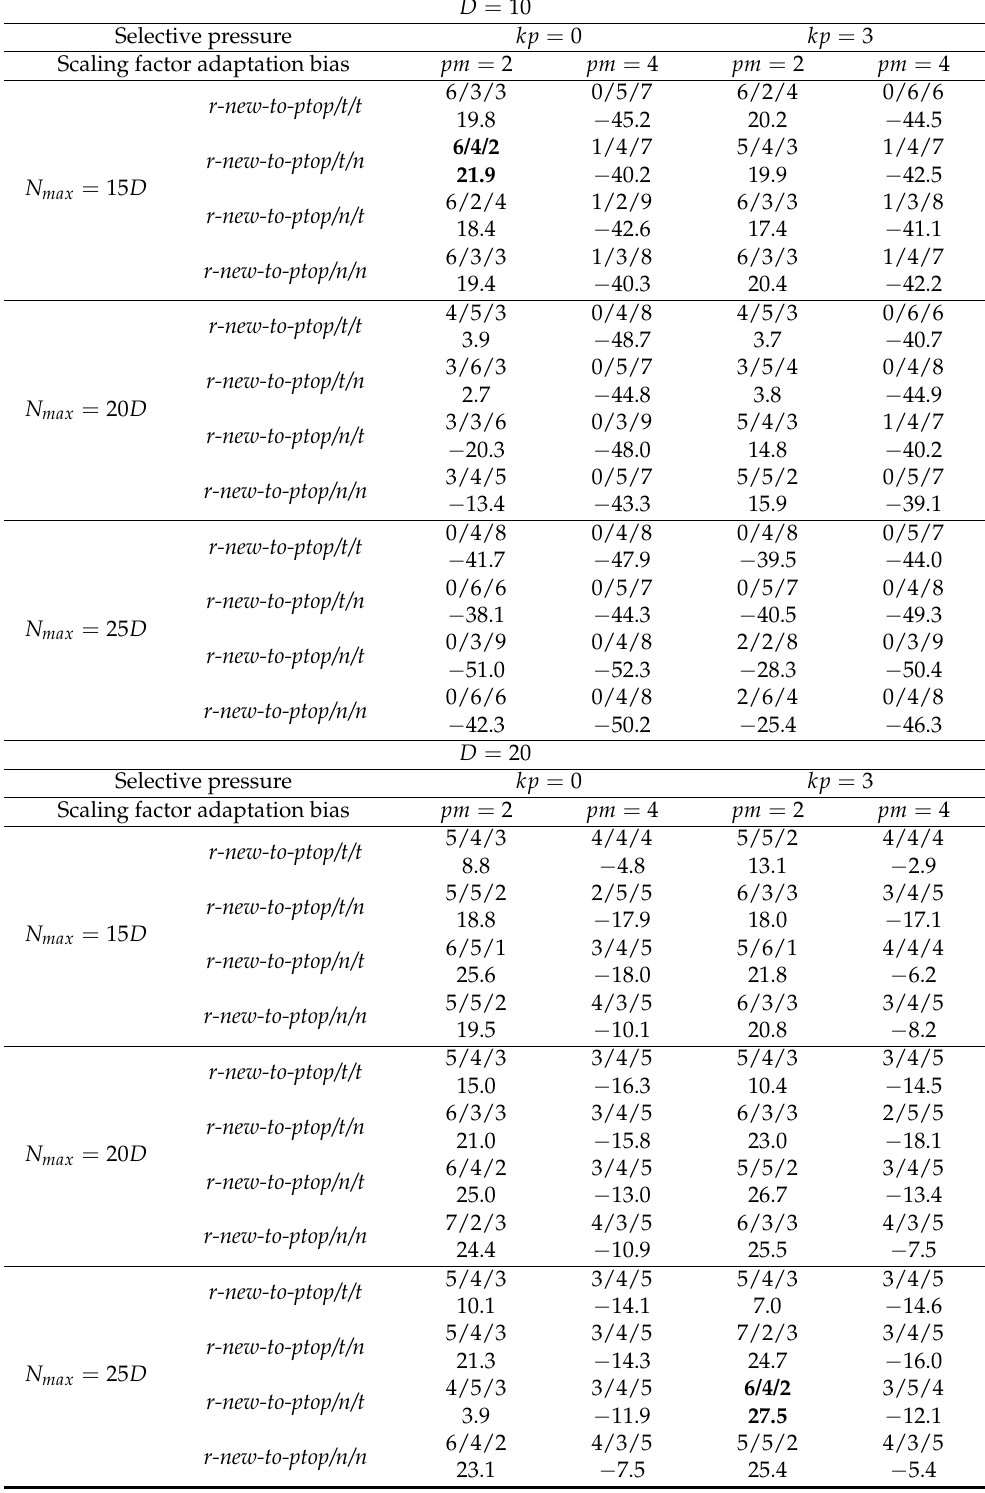
Table 1. L-NTADE vs. NL-SHADE-LBC, CEC 2022, Mann–Whitney tests and total standard